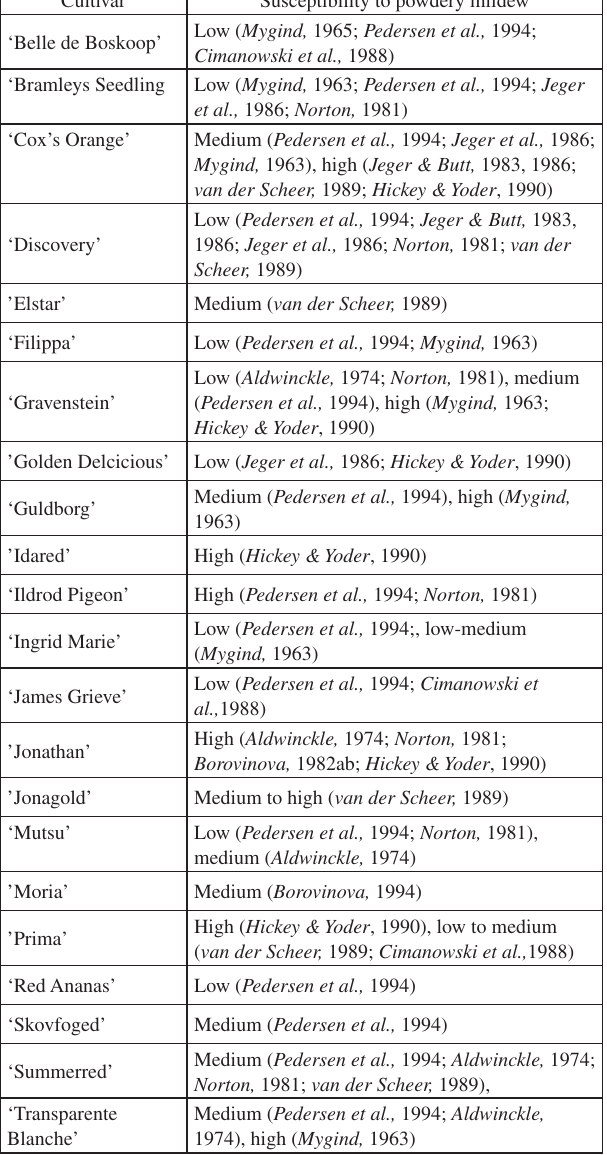
Table 1: Sampled literature sources for susceptibilty of some apple cultivars to Podoshpaera leucotricha